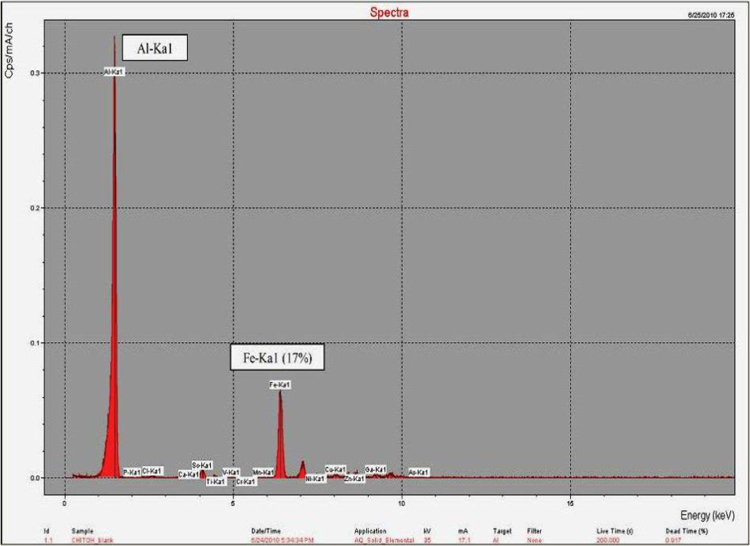
XRF spectrum of black precipitates obtained from the broth cultures of S. olleyana. Al-Ka1 = background spectra of aluminum dish where the precipitate was adhered for analysis.